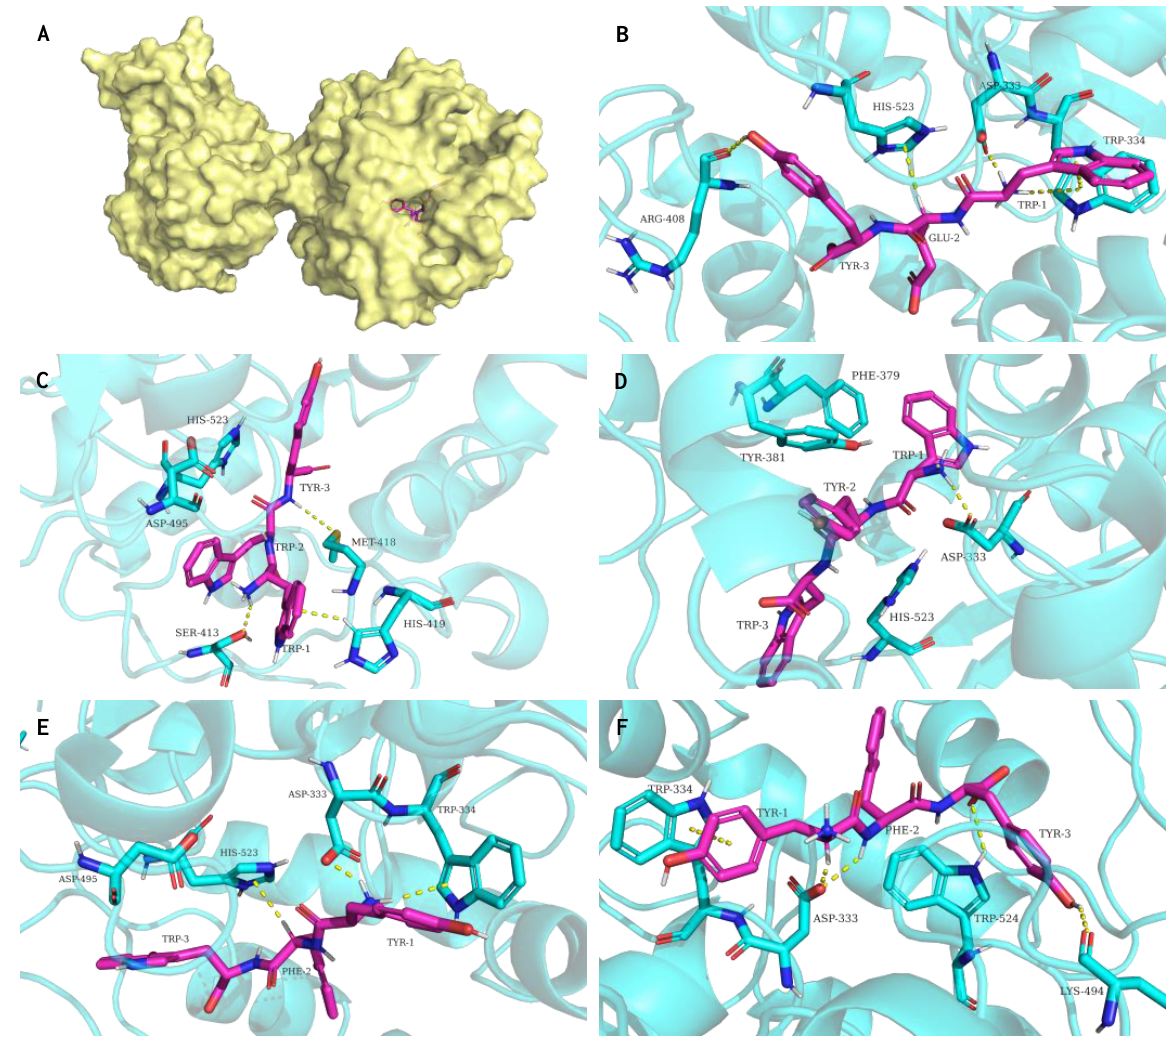
Figure 4. The conformation of sEH-peptide complex ( A ) and the interactions between sEH and pep- tides WEY ( B ), WWY ( C ), WYW ( D ), YFW ( E ), and YFY ( F ). The X-ray structure of human sEH (PDB code: 1ZD3) was obtained from the RCSB Protein Data Bank (https://www.rcsb.org, accessed on 10